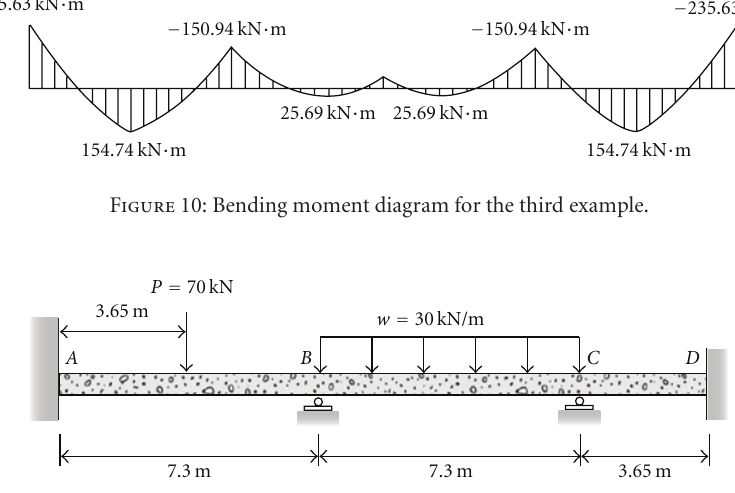
Figure 11: Continuous beam for the fourth